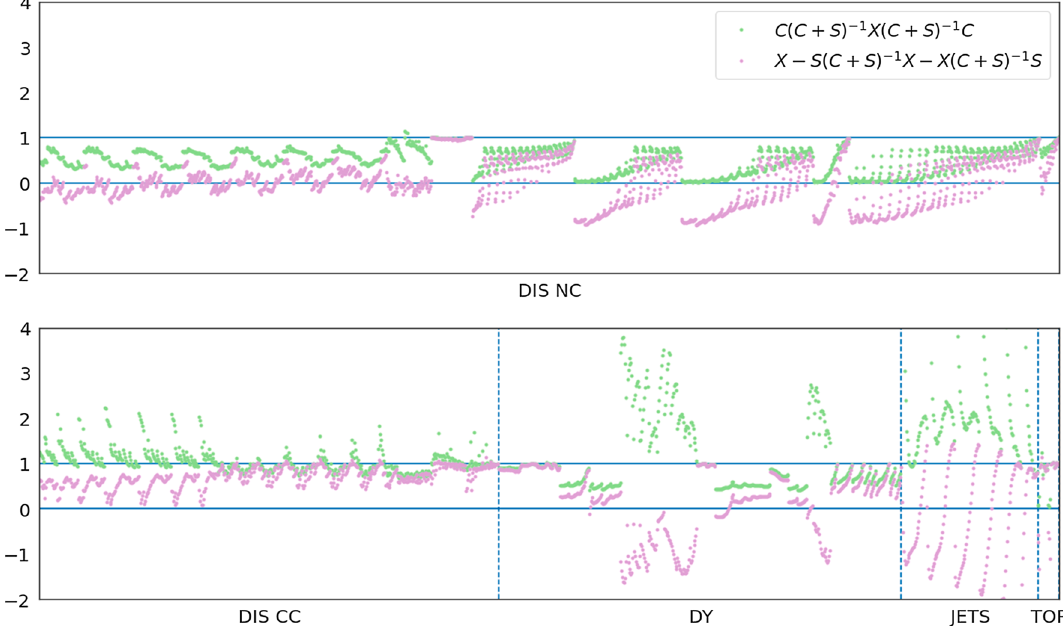
Fig. 11 The contributions to the diagonal elements of the correlated PDF uncertainty normalised to diagonal elements of X: ( X − S ( C + S ) − 1 X − X ( C + S ) − 1 S ) ii / X ii (lilac), and ( C ( C + S ) − 1 X ( C + S ) − 1 C ) ii / X ii (see Eq. (4.36) (green)